Question: What visual encoding does this figure use to show its data?
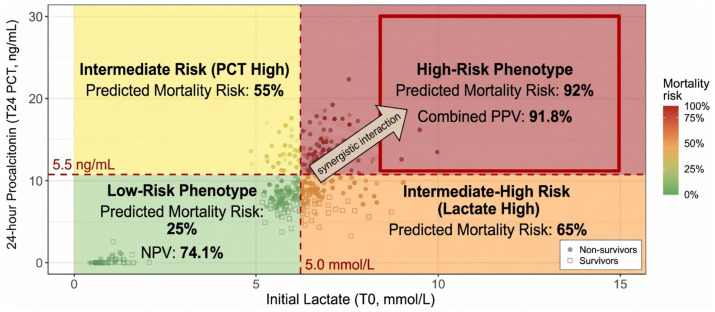
Answer: scatter